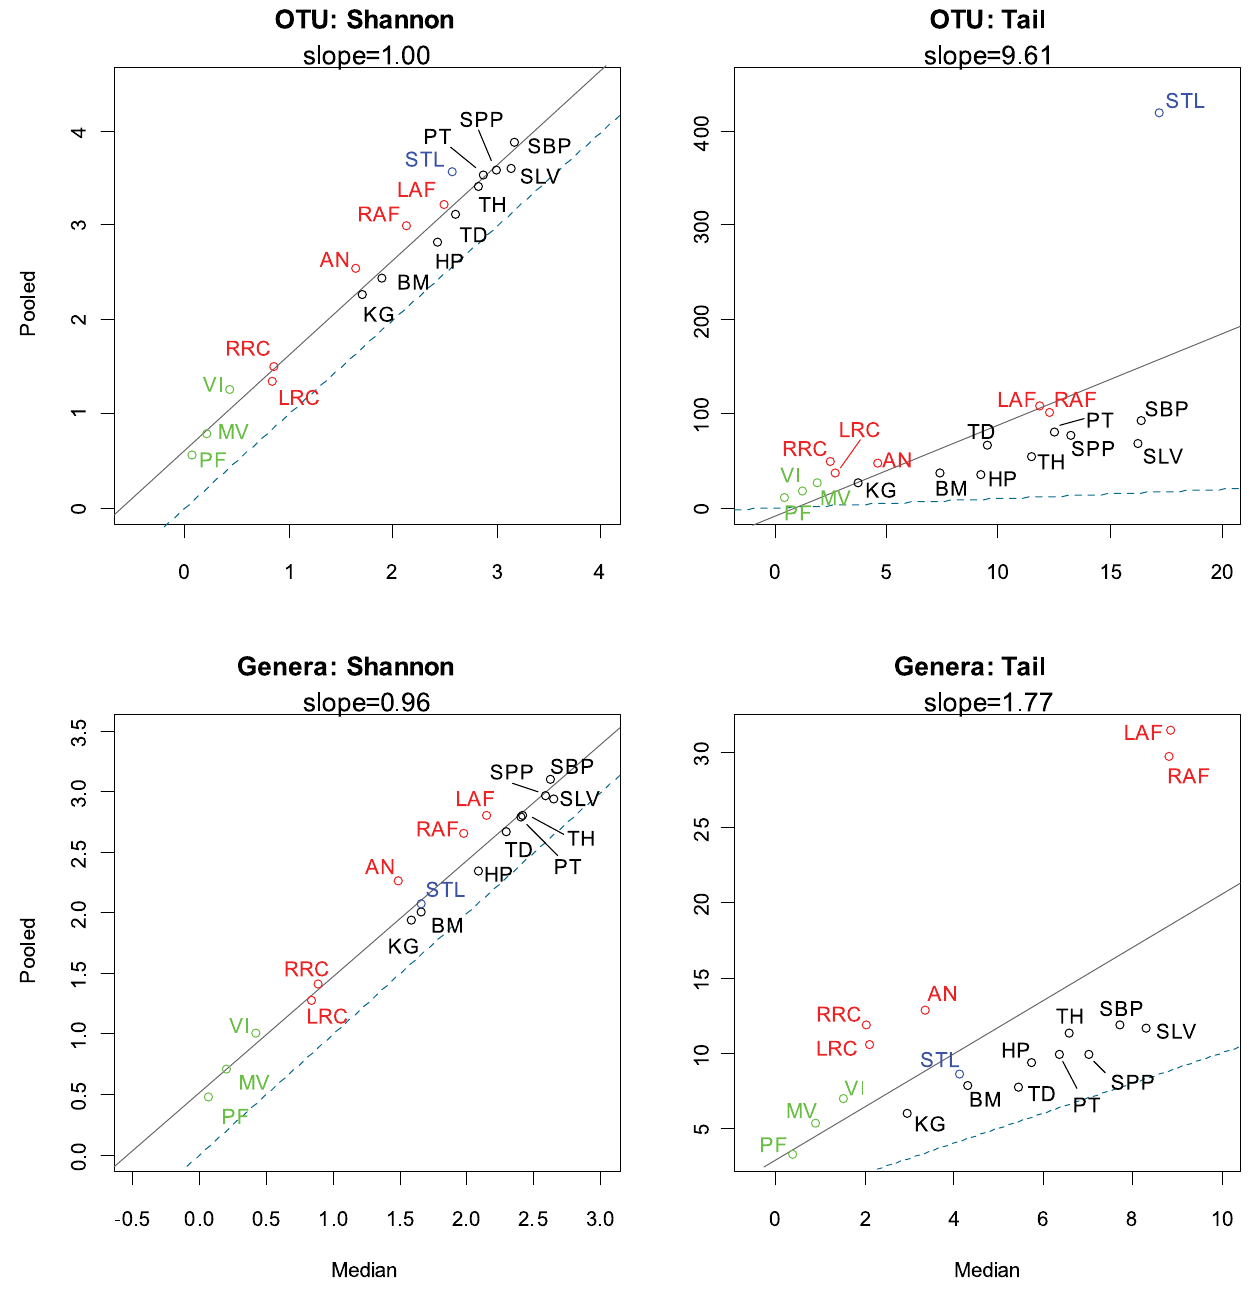
Figure 3. Comparison of diversity indices for median versus pooled taxonomic profiles. Simple regression lines were drawn in solid black for each median individual versus pooled samples scatterplot. The dashed blue lines (slope =1, y-intercept =0) represent where a hypothetical (median = pooled) relationship would exist if all individuals had identical taxonomic profiles. Both the OTU-based and genera-based comparisons using the Shannon diversity index indicate only a slight and almost constant elevation of the diversity between the median individual and pooled samples. However, t is able to capture the lengthening tail attributed to the low abundant taxa that are exclusive to certain individuals. See Table S2 for a mapping of abbreviations to habitat names. Green, red, black and blue points represent vaginal, skin, oral, and stool body regions,